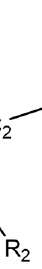
Figure 9. Mid-IR spectra of ( a ) unconfined [C 2 mim]FeCl 4 and [C 2 mim]FeCl 4 confined within ( b ) 8.36, ( c ) 7.36, and ( d ) 5.39 nm mesoporous silica.